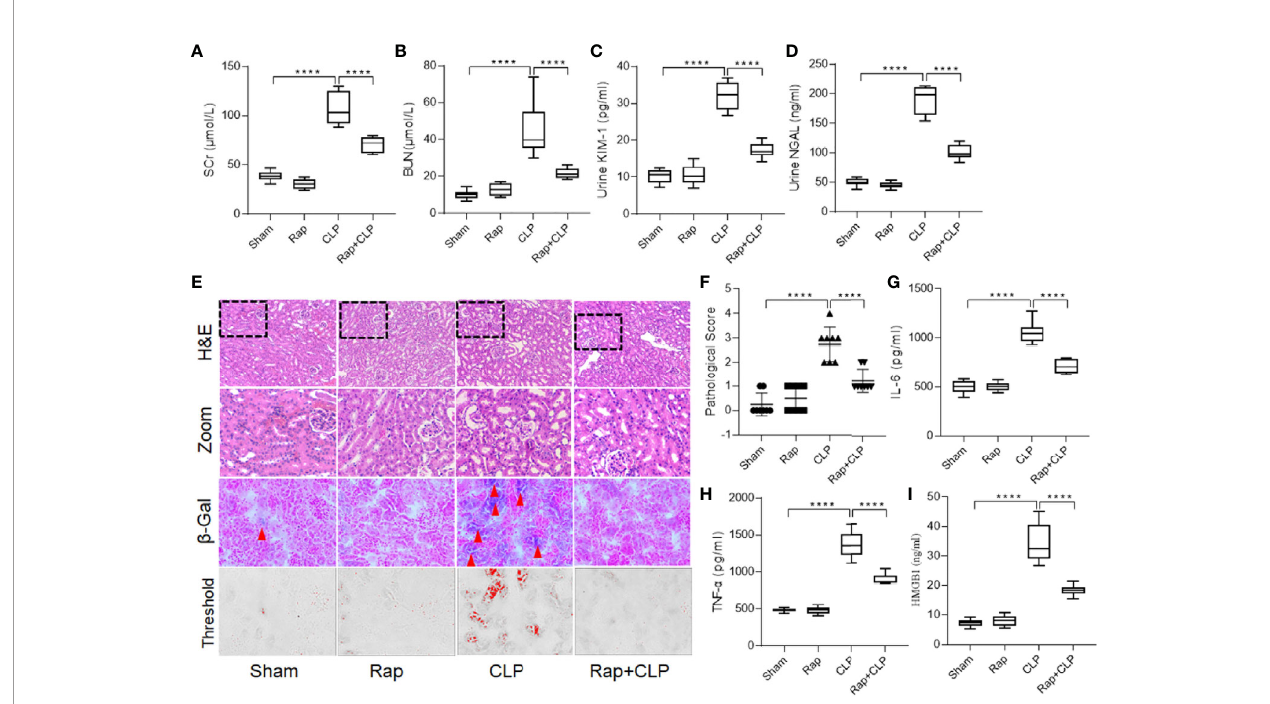
FIGURE 2 | Rapamycin restores renal function and attenuates septic in fl ammatory response. Male Sprague-Dawley rats were treated with or without rapamycin 1 mg/kg i.p. for 1h before CLP and were sacri fi ced at the time point of 18-h after surgery. Renal function alternation, renal necrosis and in fl ammatory cytokines were detected. (A – D) levels of SCr, BUN, urinary KIM-1 and NGAL among the four groups. (E) Renal damage and senescence of rats among the four groups (H&E; scale bar 100 m m). (F) Kidney histopathology evaluation scores among the four groups. (G – I) levels of IL-6, TNF- a and HMGB1 in kidneys among the four groups. Data are presented as mean ± SE (n = 8). **** p < 0.0001; CLP, cecal ligation and puncture; H&E, hematoxylin – eosin staining; SCr, serum creatinine; BUN, blood urea nitrogen; KIM-1, kidney injury molecule-1; NGAL, neutrophil gelatinase-associated lipocalin; IL-6, interlecukin-6; IL-8, interlecukin-8; TNF- a , tumor necrosis